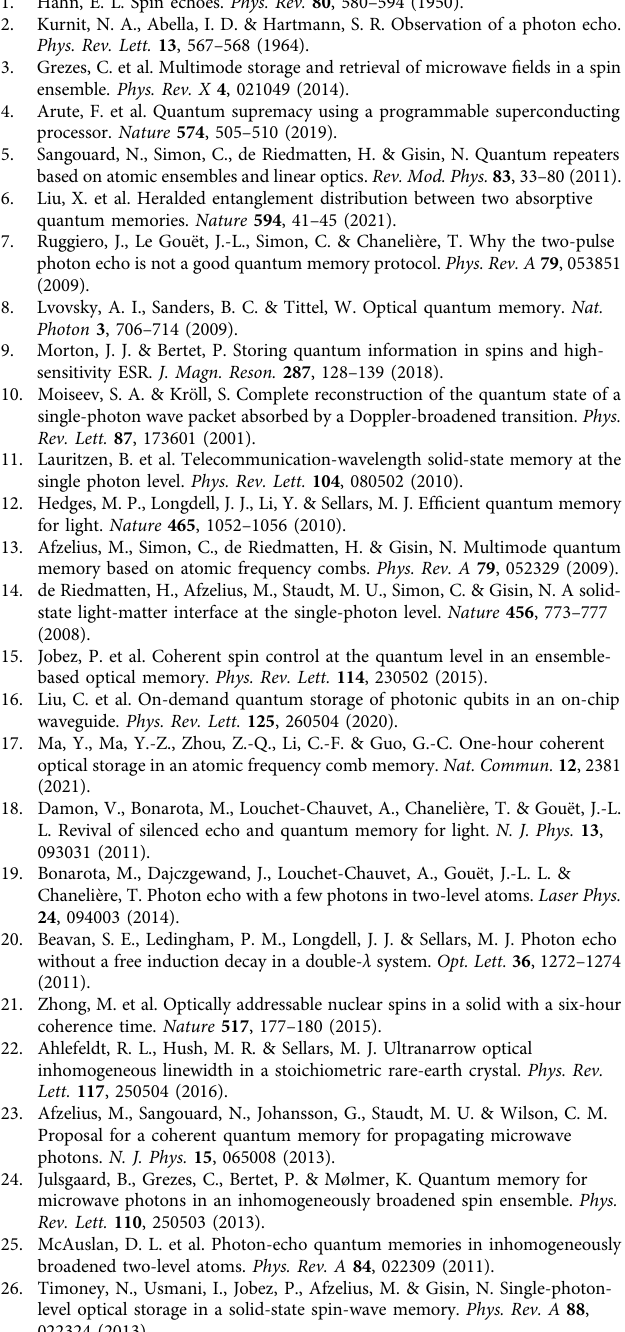
quantum communications.